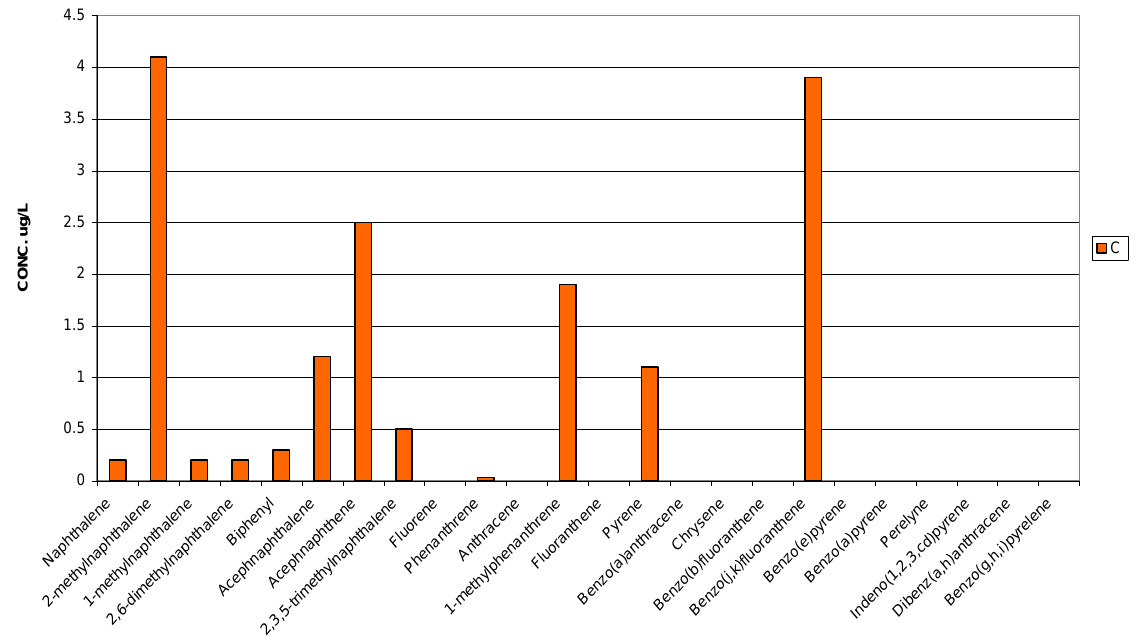
FIGURE 8. The aversge PAHs found in the Narkwa Lagoon FIGURE 8. The average PAHs found in the Narkwa